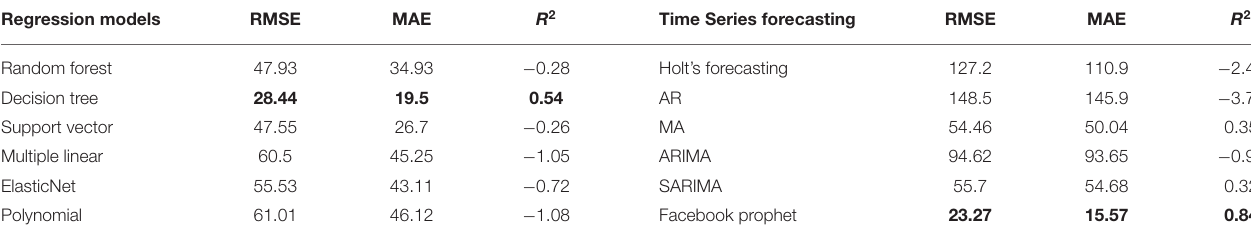
TABLE 5 | Performance metrics comparison table for Mumbai.